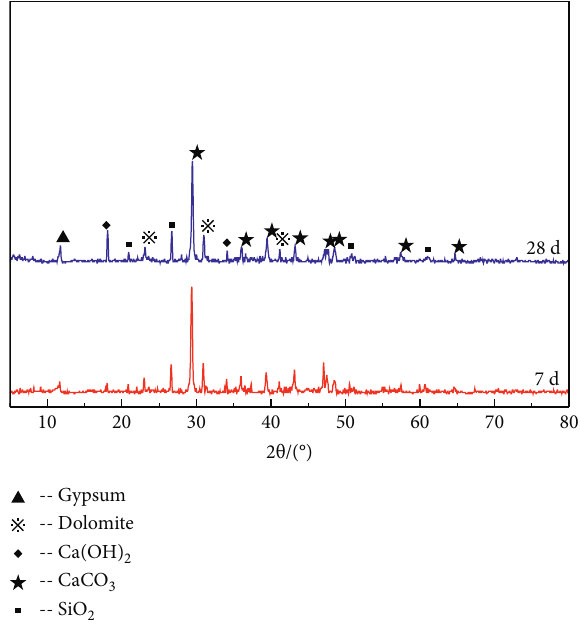
Figure 13: XRD patterns of WCP70WR0.05 group at 7 and 28